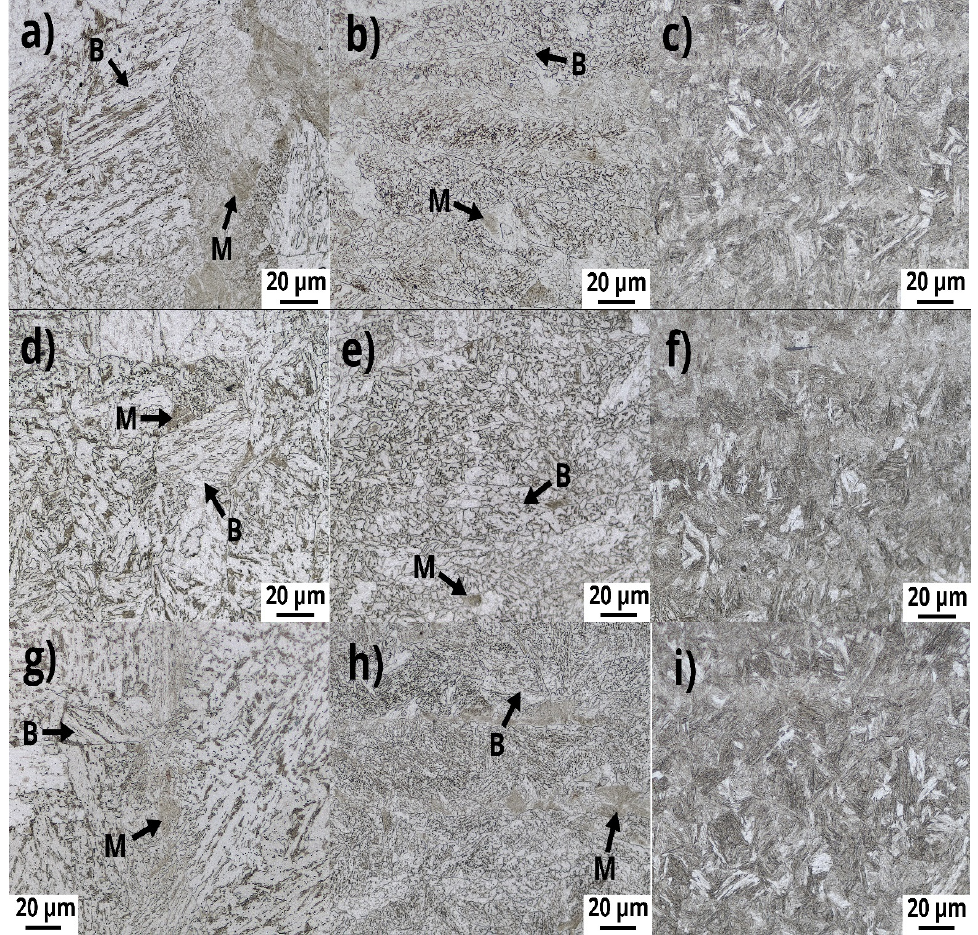
Figure 2. The microstructure of steel Nb, V–Nb, and Ti–Nb for hot-forged, hot-rolled, and low- temperature tempering (QT) conditions. Marks “B” and “M” represent bainite and martensite, respectively. Etched state, light microscopy. ( a ) Steel Nb, hot-forged; ( b ) steel Nb, hot-rolled; ( c ) steel Nb, QT; ( d ) steel V–Nb, hot-forged; ( e ) steel V–Nb, hot-rolled; ( f ) steel V–Nb, QT; ( g ) steel Ti–Nb, hot-forged; ( h ) steel Ti–Nb, hot-rolled; ( i ) steel Ti–Nb, QT. The microstructures of hot-forged (Figure 2a,d,g) and hot-rolled (Figure 2b,e,h) conditions for all three samples are heterogeneous due to mixed bainitic-martensitic microstructure with predominating bainite. Fractions of martensite are detected in areas of solute enrichment as a part of casting history and recognized as microstructural banding after hot deformation. Microstructural banding as alternating parallel bands is hardly noticeable but still detectable in rolled and QT conditions. The side effect of enrichment of